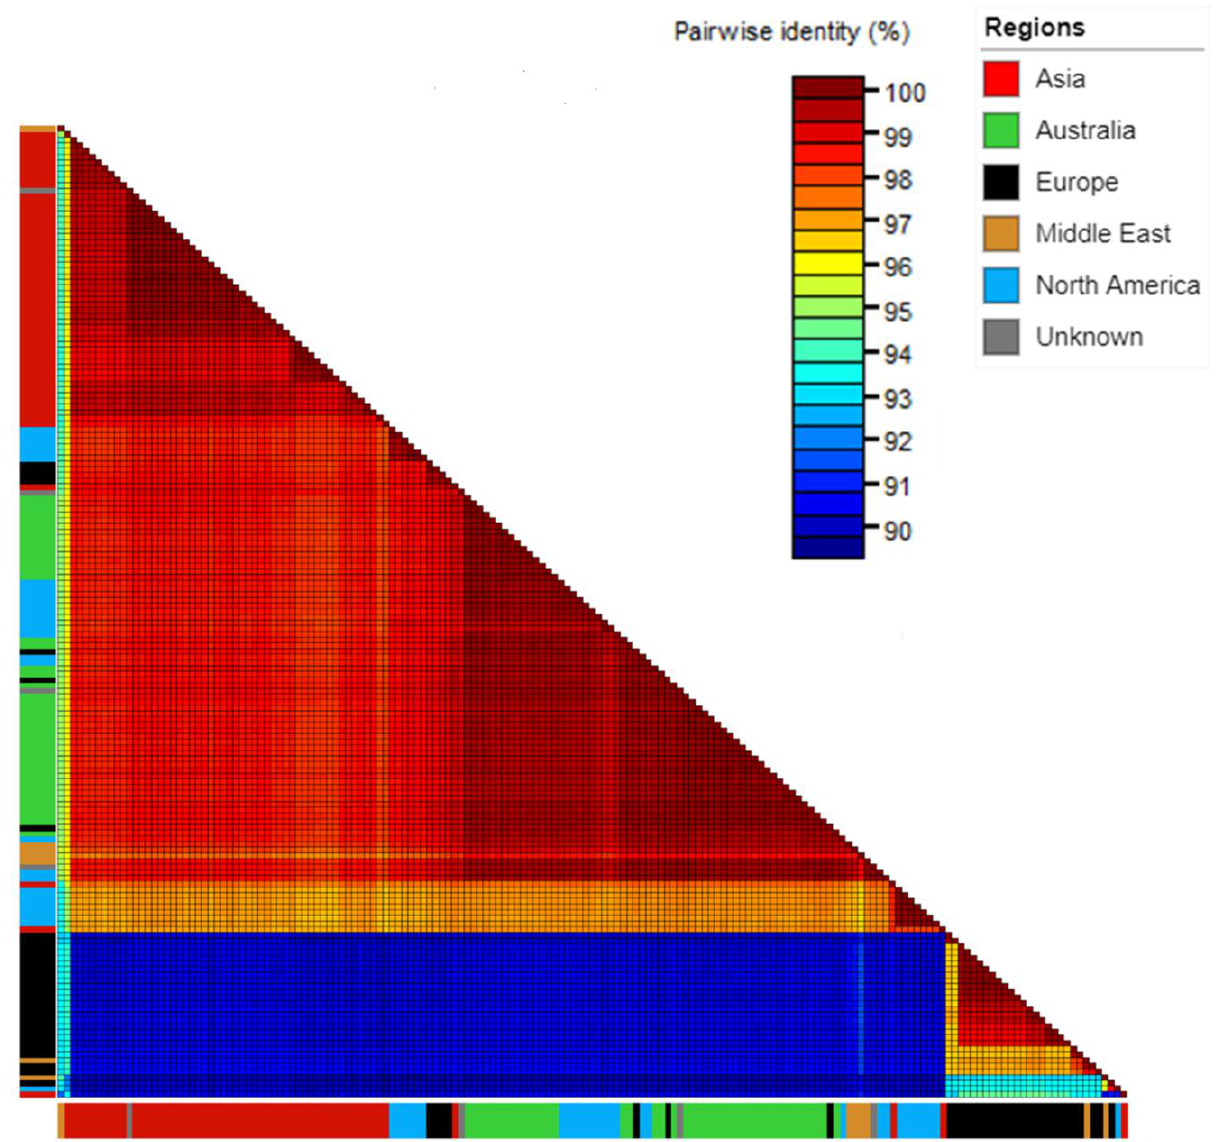
Figure 2. Sequence Demarcation Tool matrix showing percent pairwise nucleotide similarity for the full coding sequence region genomes of Australian, seed interception and global cucumber green mottle mosaic virus isolates. Colour strips on edges denote isolate collection region: Asia—red, Australia—green, Europe—black, Middle East—orange, North America—blue, and unknown isolates (seed interceptions) — grey.